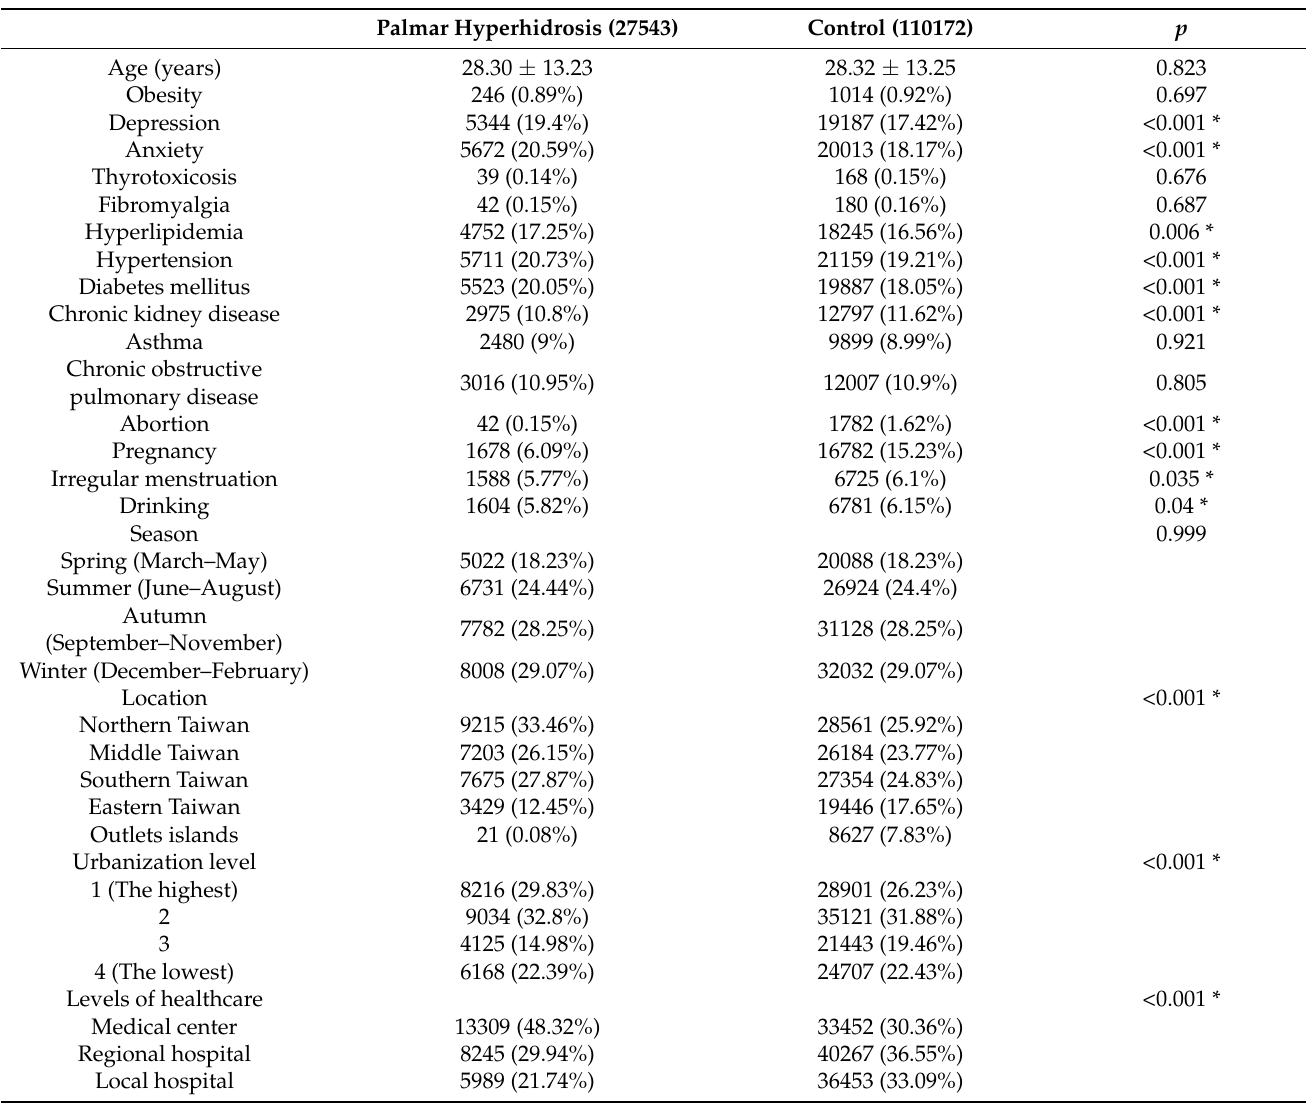
Table 1. Characteristics of the study cohort at baseline.